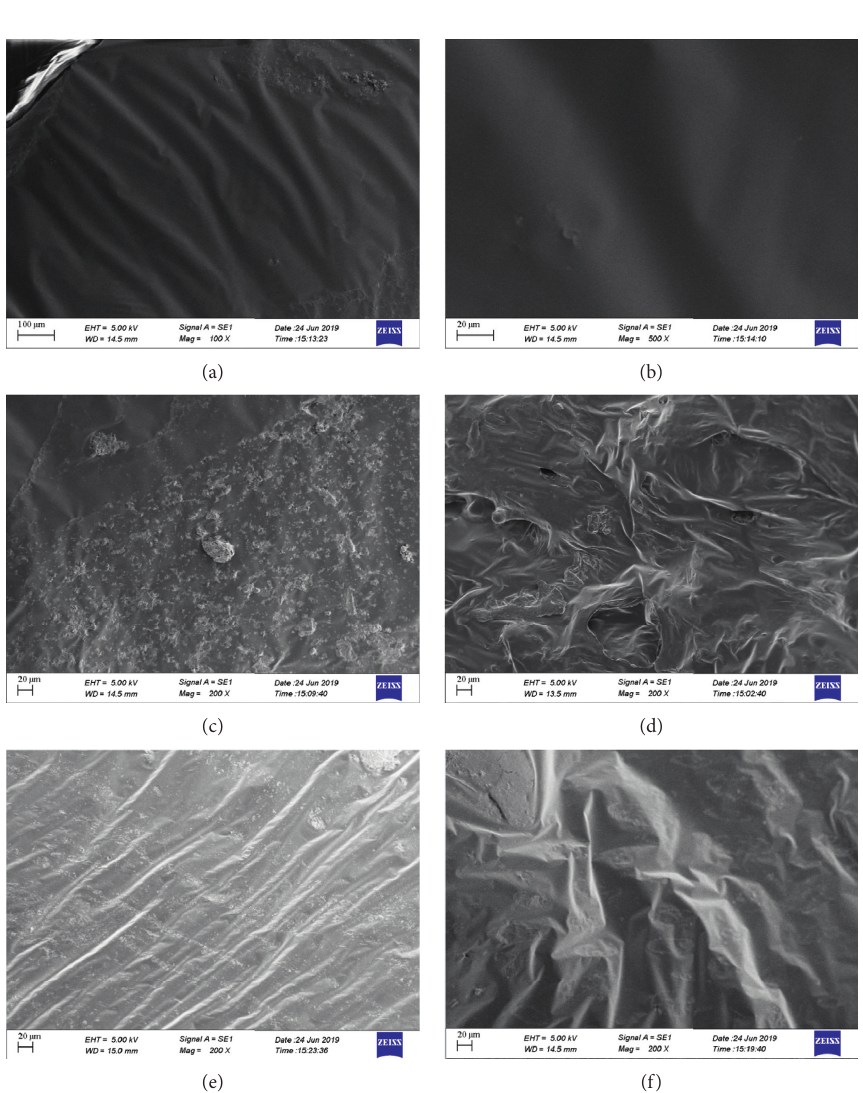
Figure 11: SEM test results. (a, b) The original asphalt before aging. (c) The original asphalt after aging. (d) WBA. (e) Z40. (f)